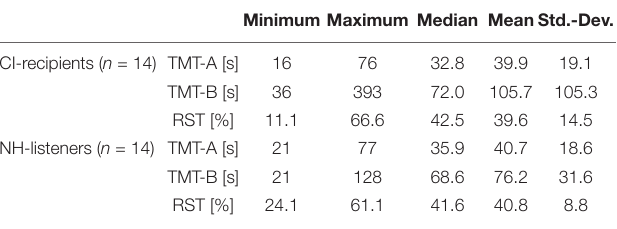
TABLE 2 | Outcome of the neuropsychological tests regarding processing speed (TMT-A), executive control (TMT-B), and working memory capacity (RST). Minimum Maximum Median MeanStd.-Dev.